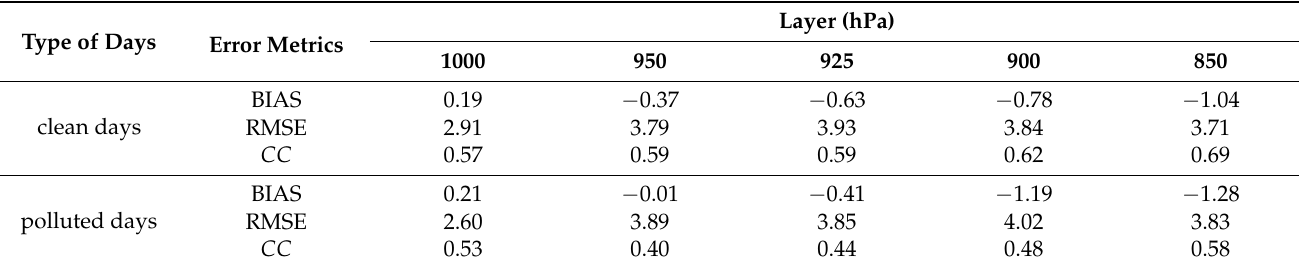
Table 5. Error metrics for the wind speed in